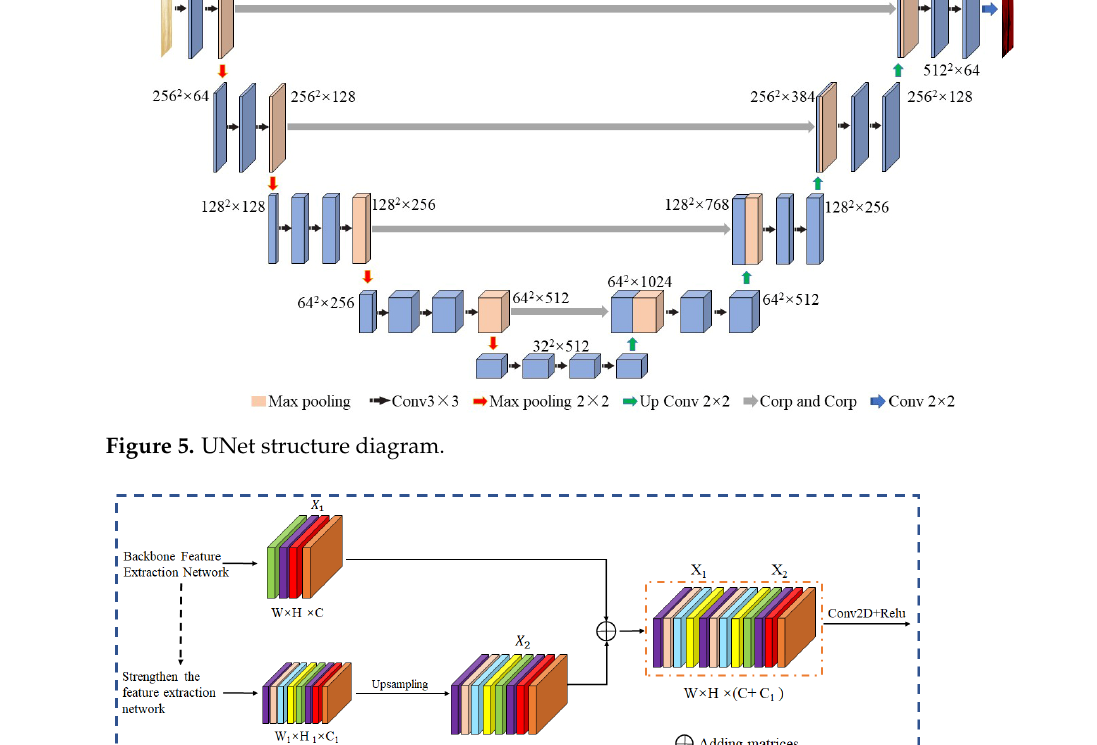
Figure 6. Feature extraction schematic.